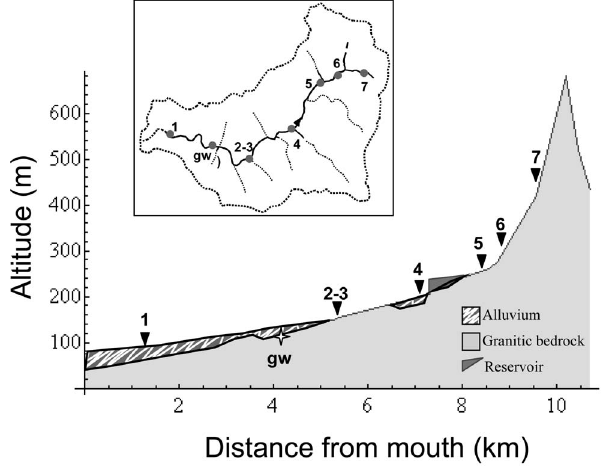
Figure 1. Sampling point locations. Sampling point locations along the longitudinal-altitudinal profile and the fluvial network (inset). Triangles: surface waters. Star: riparian groundwater.